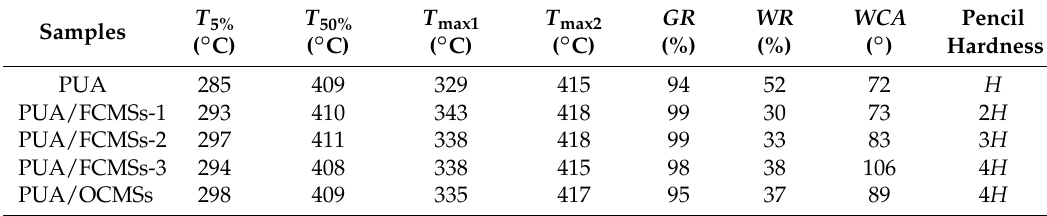
Table 1. The comprehensive performances of UV-curable coatings.